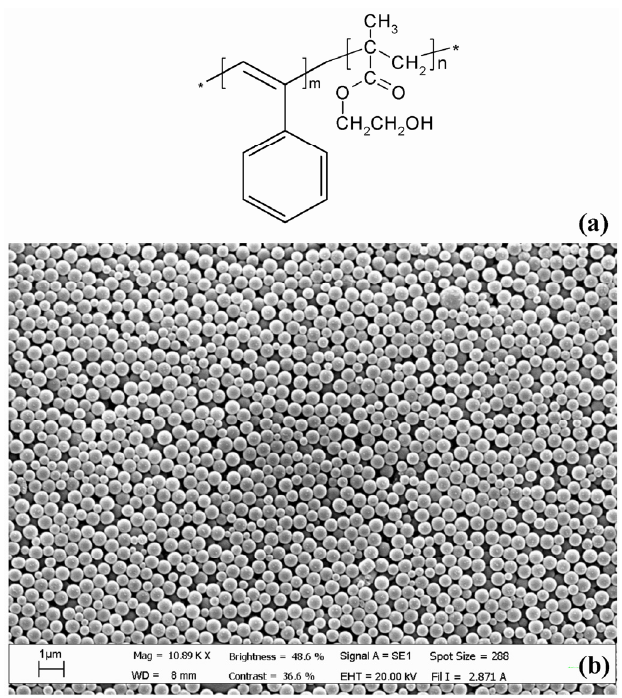
Figure 5. Chemical structure of P(PA/HEMA) (a). Morphology of the nanostructured polymer film used as CIM as seen at SEM